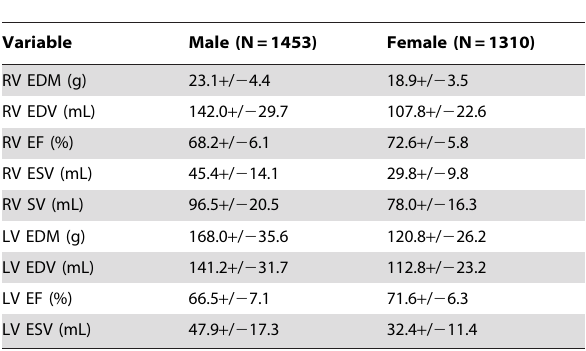
Table 3. Cox proportional hazards models for RV measures and time to